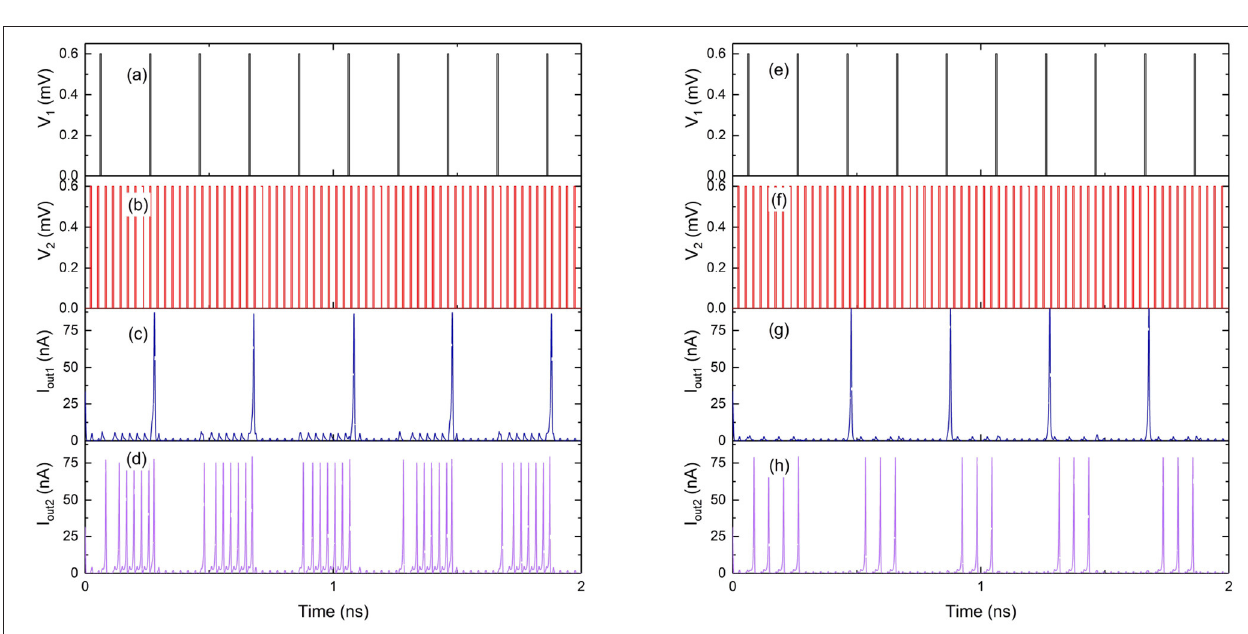
FIGURE 11 | Simulation results of the 2 × 2 synapse network shown in Figure 10 . (a–d) Capacitors C 1 and C 2 are both chosen to be 3 fF . (e–h) Capacitors C 1 and C 2 are both chosen to be 6 fF . (a,e) Voltage pulse input at V w of the binary synapse circuit shown in Figure 10 . (b,f) Voltage pulse input at V r . (c,g) Current output at I b 1 . (d,h) Current output at I out